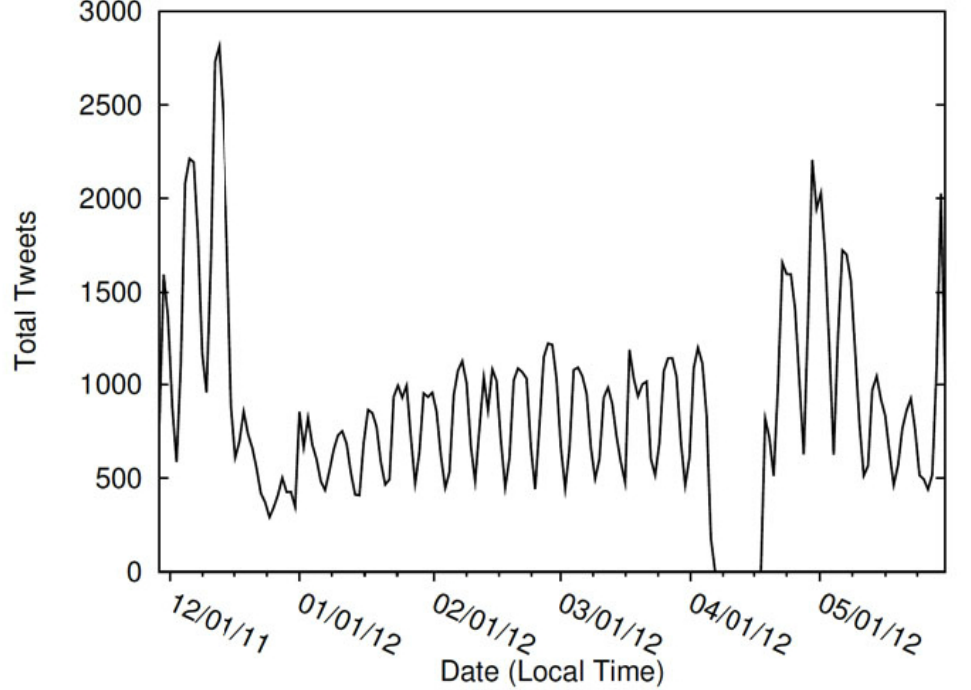
Figure 2. Distribution of Adderall-related tweets over 6